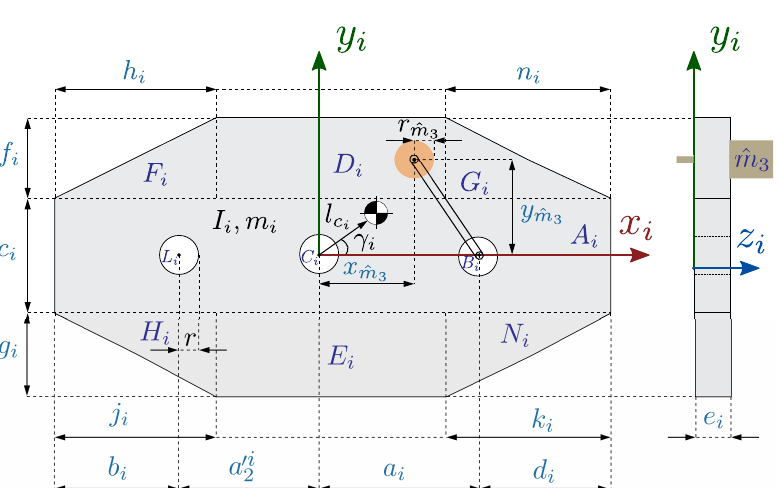
Figure 2. Design variables of the i -th link. The distance a (cid:48) i = a fixed length a (cid:48) i 2 and the cylinder (hole) L 4 is included. For the rest of the links ( 2 = 0, the cylinder L length a (cid:48) i i , and the actuator placed in 2 and the actuator are not